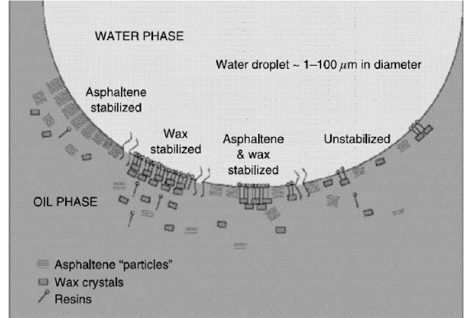
Figure 2. Water in fuel oil phase with asphaltenes and resins of the fuel in the water drop [30].